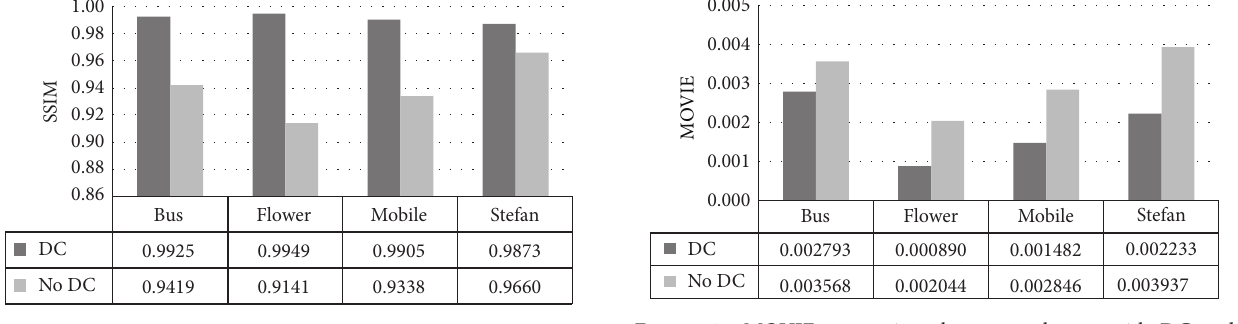
Figure15:SSIMcomparisonbetweenschemeswithDCandwithout DC.